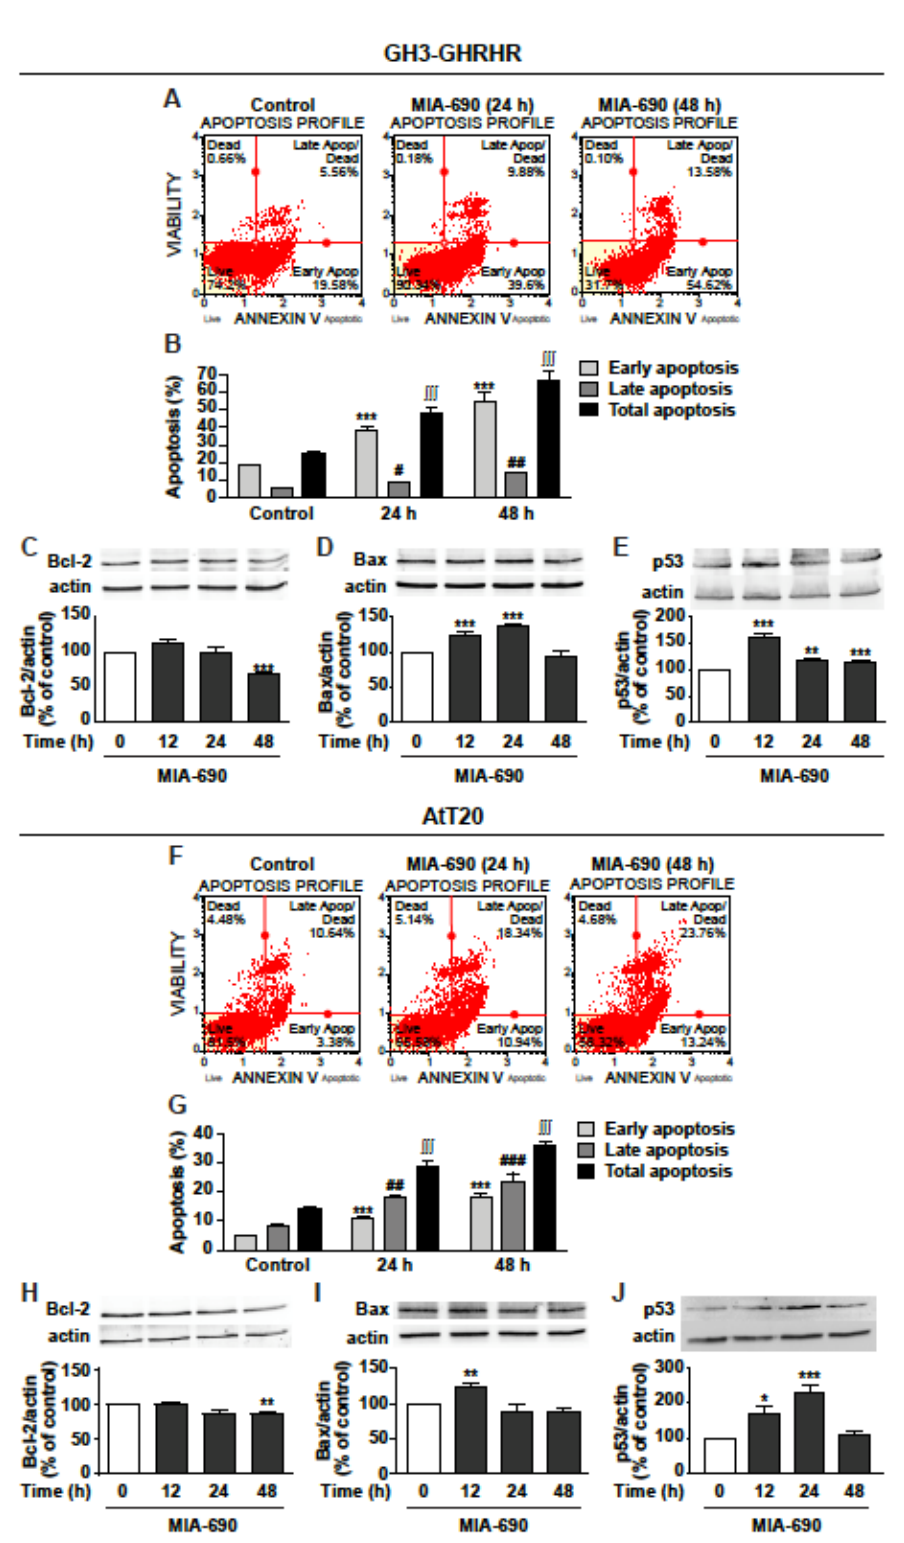
Figure 3. Proapoptotic effects of MIA-690 in GH3-GHRHR and AtT20 cells. ( A ) Representative results obtained by Muse Annexin V and Dead Cell assay in GH3-GHRHR cells cultured with 1% serum and treated for 24 and 48 h either without (Control) or with 1 µm MIA-690. ( B ) Quantification of the percentage of early apoptosis, late apoptosis and total apoptosis (early + late) in cells stained with Annexin V. Results are means ± SEM. *** p < 0.001; # p < 0.05, ## p < 0.01; p < 0.001 vs. their respective controls, by unpaired Student’s t -test ( n = 3). Representative Western blot for expression of Bcl-2 ( C ), Bax ( D ), and p53 ( E ) in cells treated with 1 µm MIA-690 for the times indicated. Equal